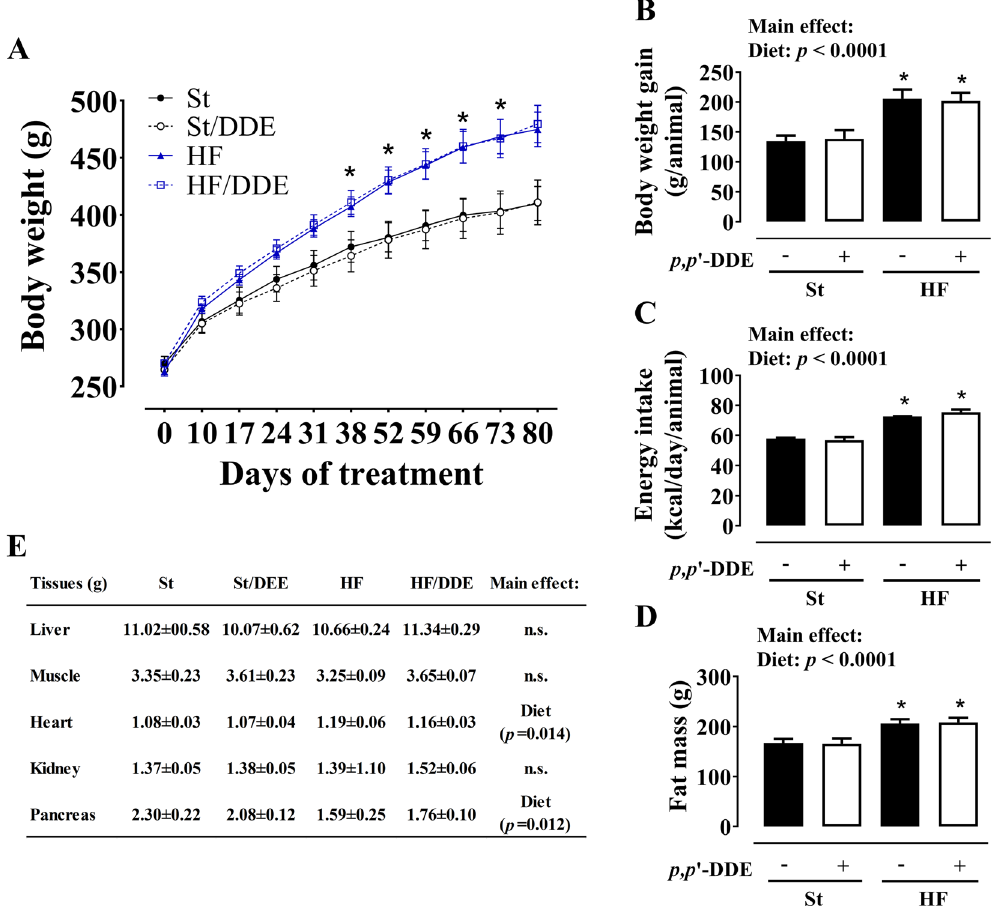
Figure 1. Weight measurements and body composition: ( A ) body weight evolution throughout the 12 weeks of treatment; ( B ) body weight gain per animal; ( C ) energy intake (kcal) per day/animal calculated trough food intake assessment; ( D ) fat mass evaluated by bioelectrical impedance at 12 weeks; ( E ) organ weights at 12 weeks. Values are represented as mean ± SEM. Statistical analysis with ( A ) two-way repeated-measures ANOVA; ( B , C , D and F ) two-way ANOVA (main effects: diet, p , p ’-DDE exposure and their interaction; p < 0.05), followed by Tukey’s multiple comparison post-hoc test: * p < 0.05 vs St and St/DDE. St, standard diet; HF, high fat diet; p , p ’-DDE, p , p